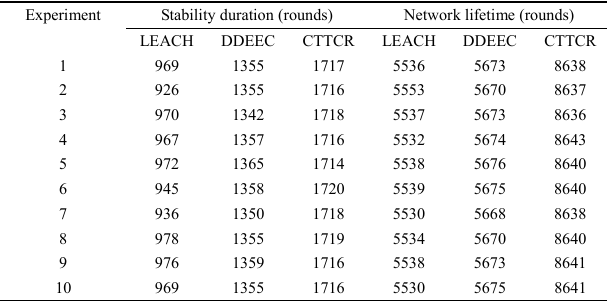
Table 2. List of stability duration and network lifetime